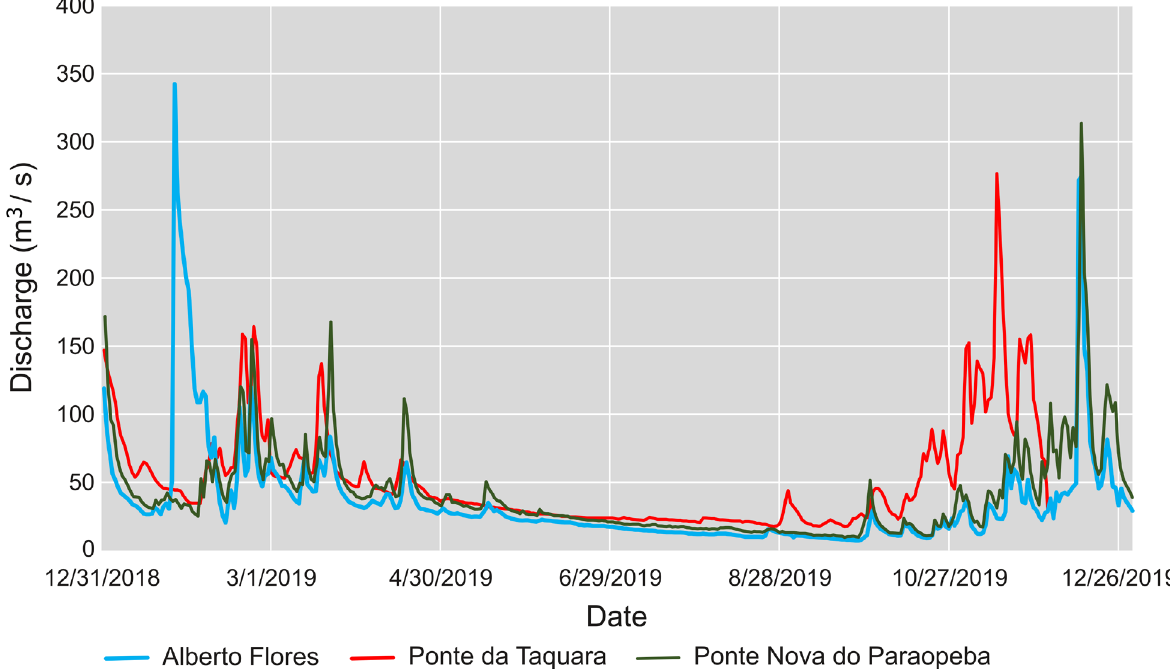
Figure 3. Hydrographs from the three gauge stations observed during 2019 (locations are shown in Figure 1). The highest discharge values were recorded between January and April, falling afterward and then increasing at the end of September in response to the variation of